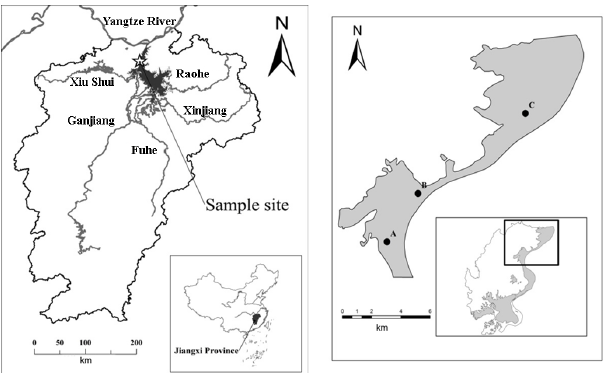
Figure 1. Location of sampling sites in Poyang